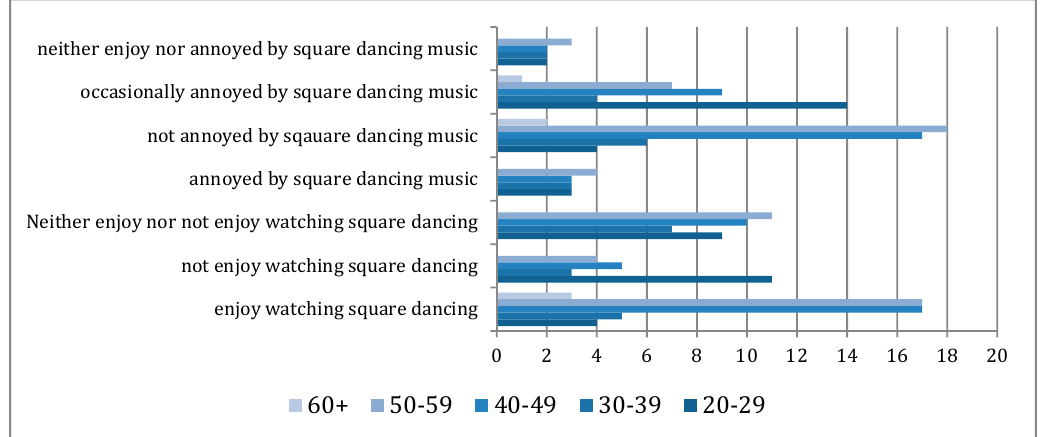
Figure 3. Responses from different age groups on the enjoyment of watching square dancing and the annoyance of square dancing music.